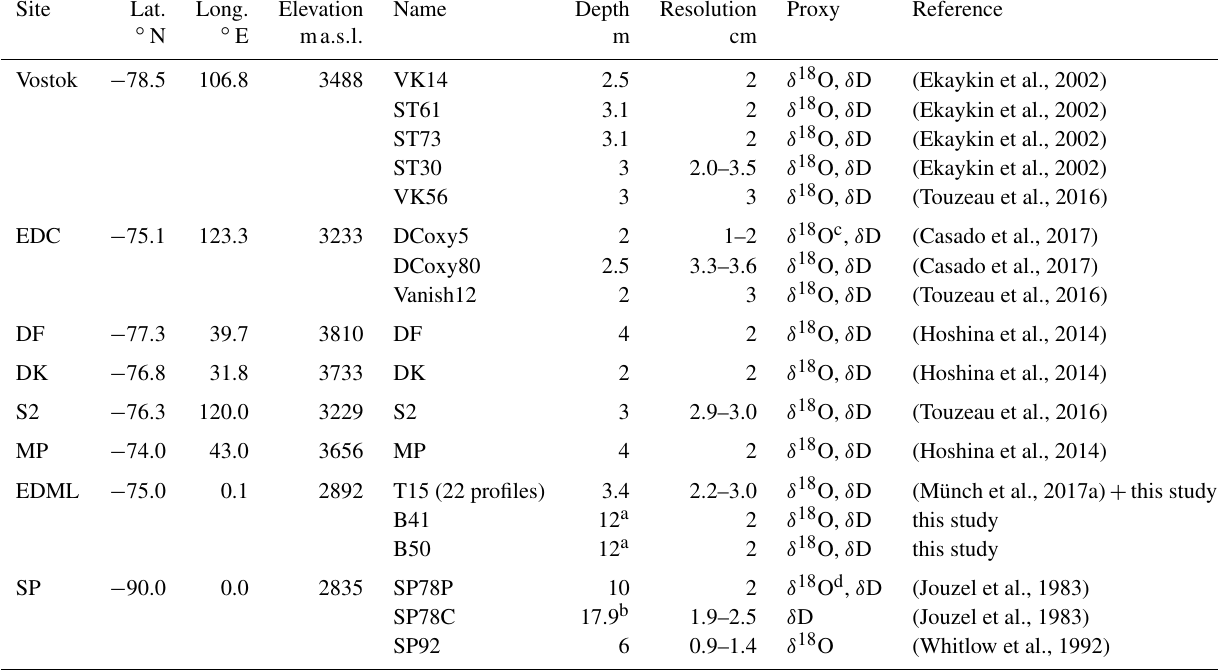
Table 1. Summary of the drilling and snow-pit sites used in this study. For each site we list latitude, longitude and elevation a.s.l. and for each corresponding record its name, the analysed depth, sampling resolution, measured proxy and original data reference. Some profiles have single missing measurements that are not included in the provided sampling resolution. The 35 missing δ 18 O samples in DCoxy80 were filled by linear regression to δ D. For SP, δ D was converted to δ 18 O using a slope of 8 to get a complete δ 18 O data set. Site